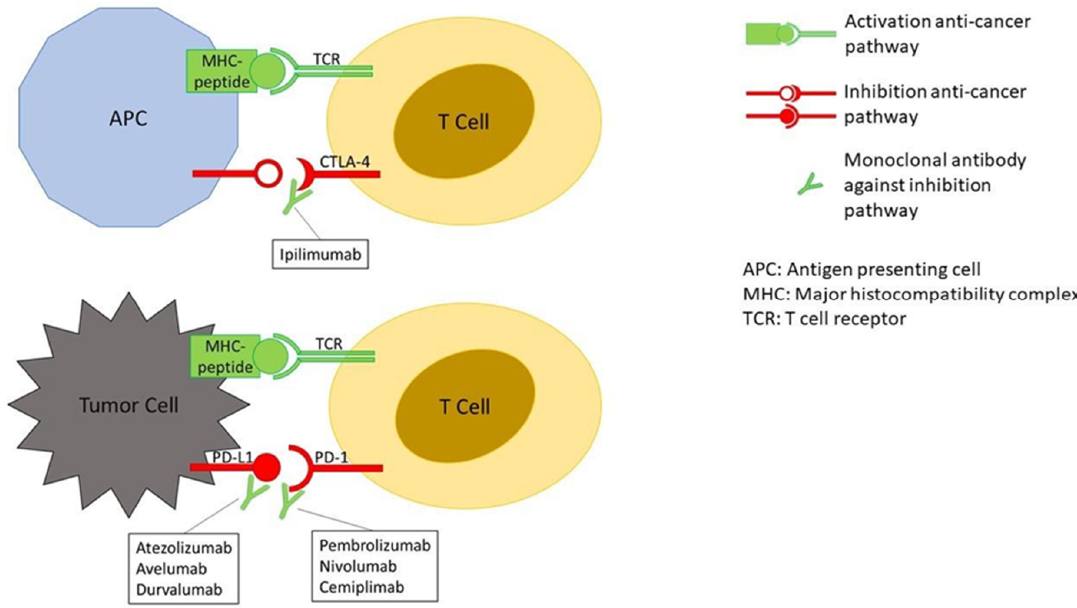
Figure 1. Mechanism of action of immune checkpoint inhibitors (ICIs). The binding together of MHC-peptide (peptide = tumor antigen) and TCR activates the anti-cancer pathway of T-cell–mediated immune response. The binding of CTLA-4 to its ligand and PD-1 to PD-L1, on the contrary, inhibit the anti-cancer pathway. The binding of monoclonal antibodies, such as ICIs, to CTLA-4, PD-1 or PD-L1 prevent the deactivation of the anti-cancer pathway.